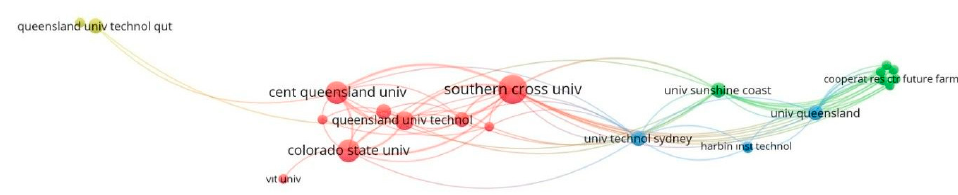
Figure 4. The organization co-authorship network of Web of Science research on biodiesel production from essential